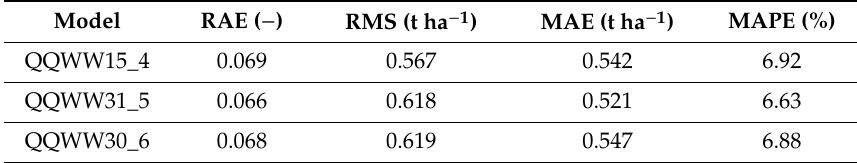
Table 4. Measures prediction ex post of analyzed neural models.